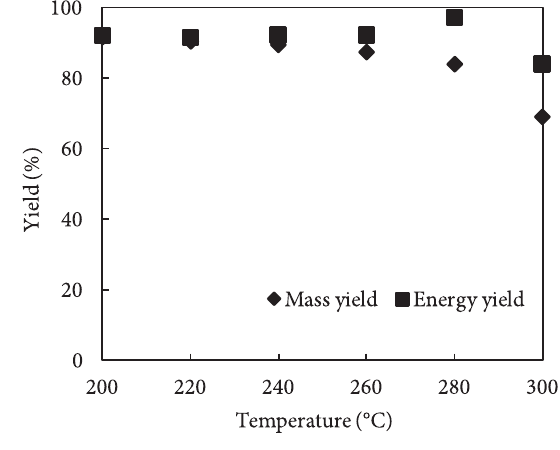
Figure 2. Mass and energy yield